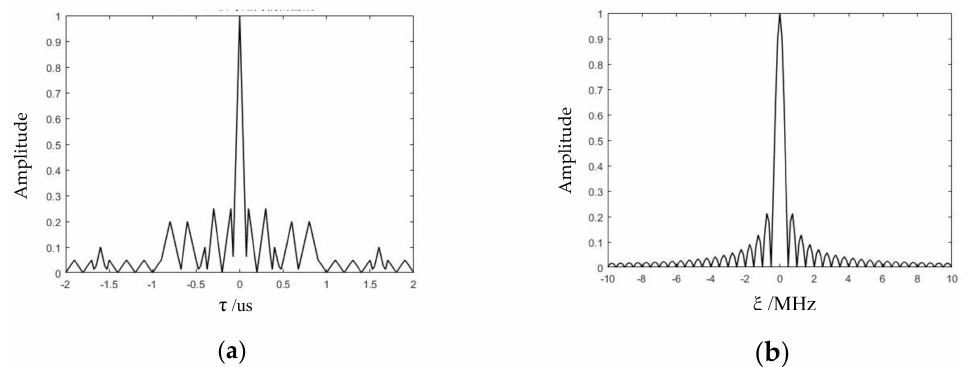
Figure 5. Zero-delay cut and the zero-Doppler cut of the 2D ambiguity function. ( a ) Zero-Doppler cut. ( b ) Zero-delay cut.